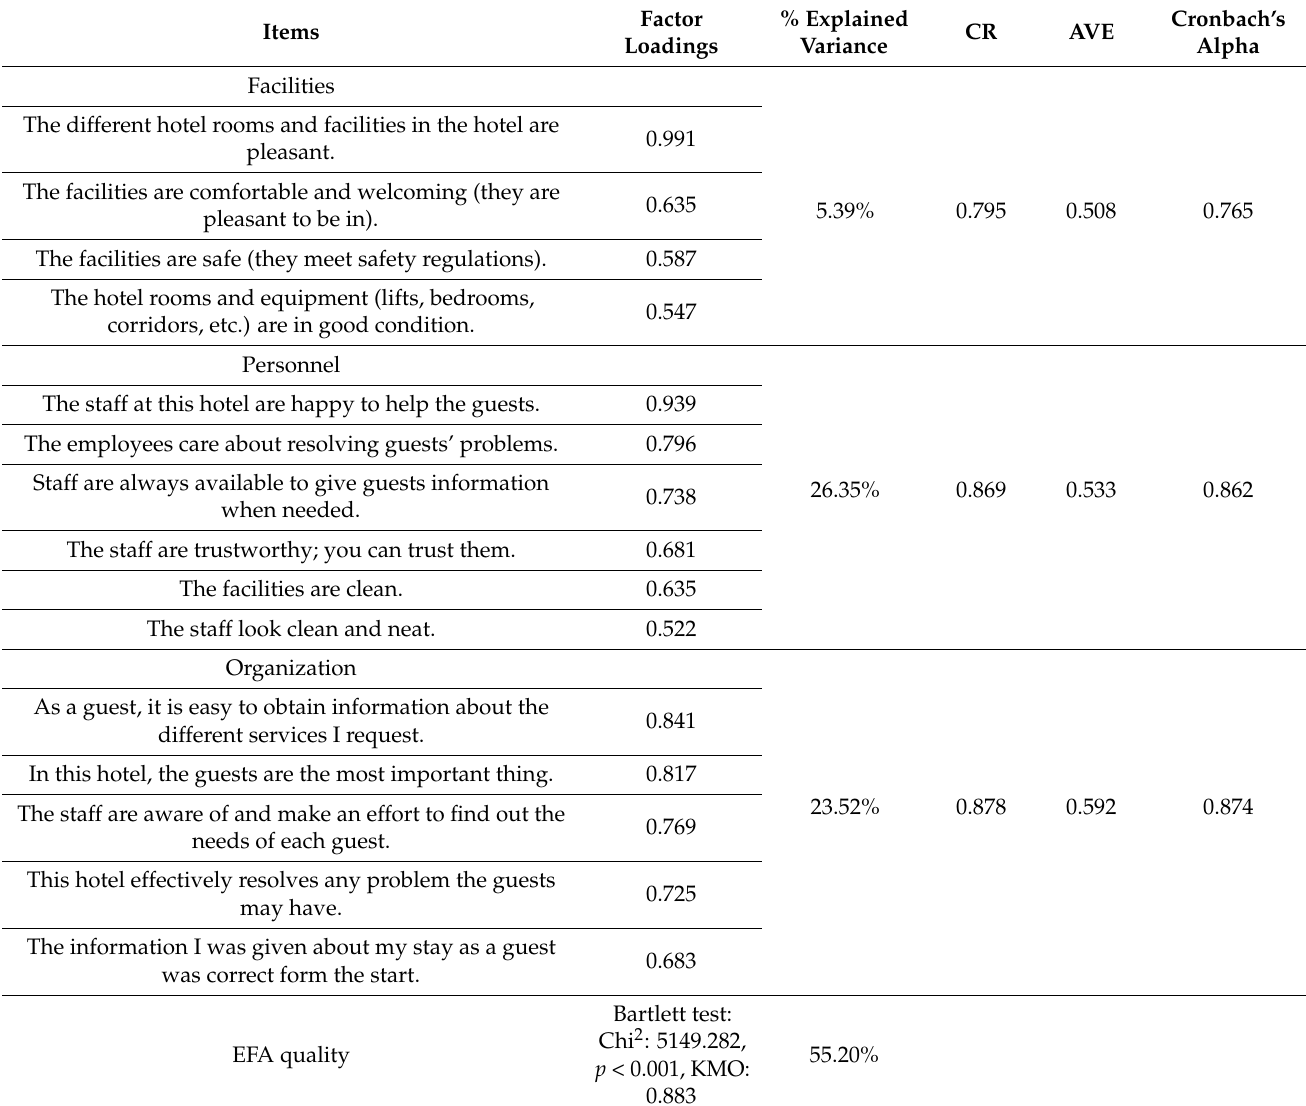
Table 3. Measurement validations.